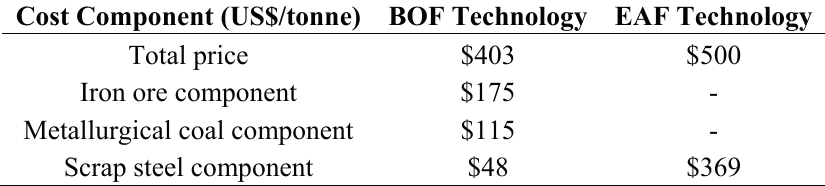
Table 2. Production cost of two major steelmaking technologies, with major ingredient component costs